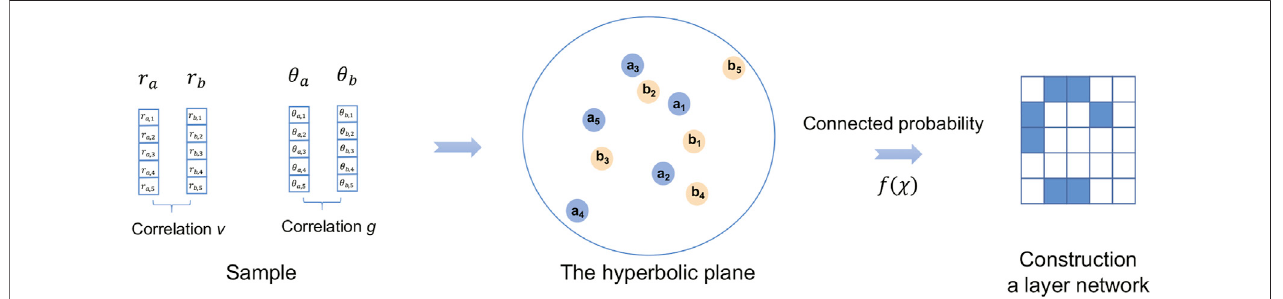
FIGURE2| The fl owdiagramofconstructionteachlayerofarti fi cialinterdependentnetworks.Yellownodesandbluenodesarerepresentedin-directionnodesand out-direction nodes, respectively.